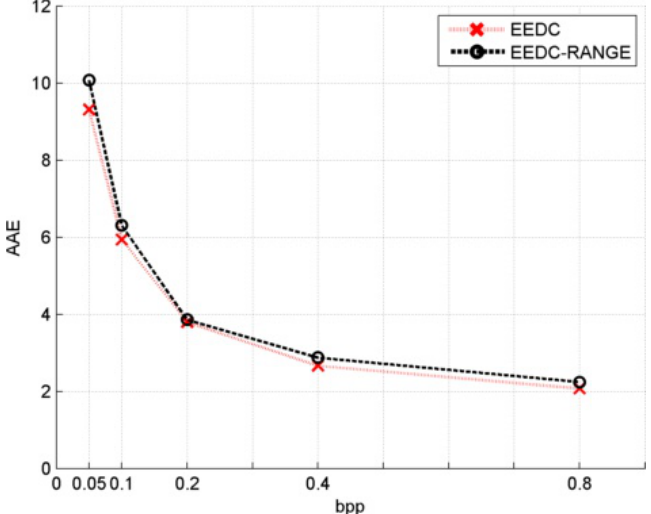
Figure 6. AAE for image horse and modified gray values compression with range